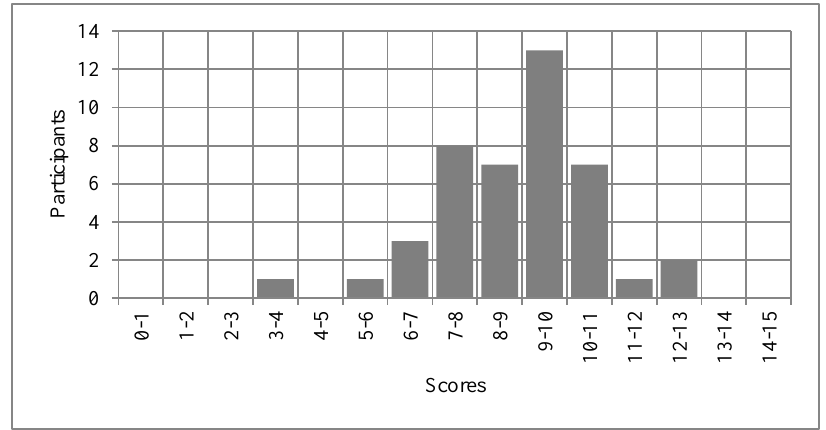
Fig. 2. Testing results on the topic "Charged Particles Movement in Electric and Magnetic Fields" with the optimal ratio of the questions complexity and the time for solving